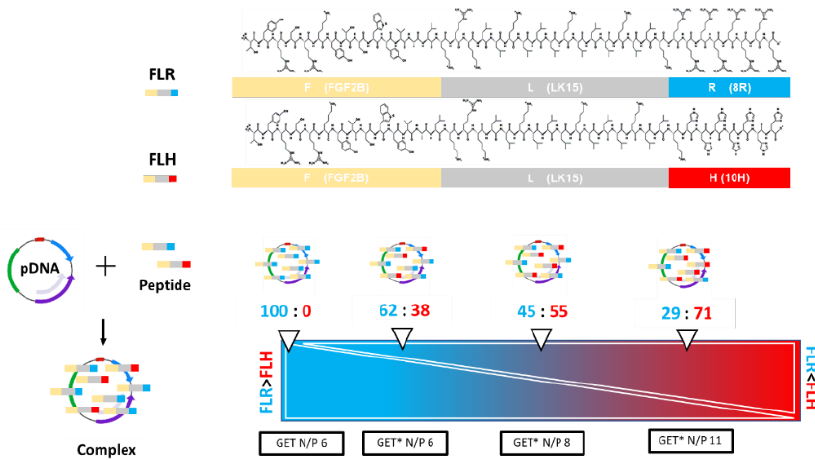
Figure 1. The GET* peptide is comprised of FLR and FLH combinations. Nanoparticles were com- complexed by mixing negatively charged pDNA with positively charged GET* peptide plexed by mixing negatively charged pDNA with positively charged GET* peptide (FLR/FLH). The N/P ratio increases with increasing proportions of FLH in the FLR/FLH mixture.